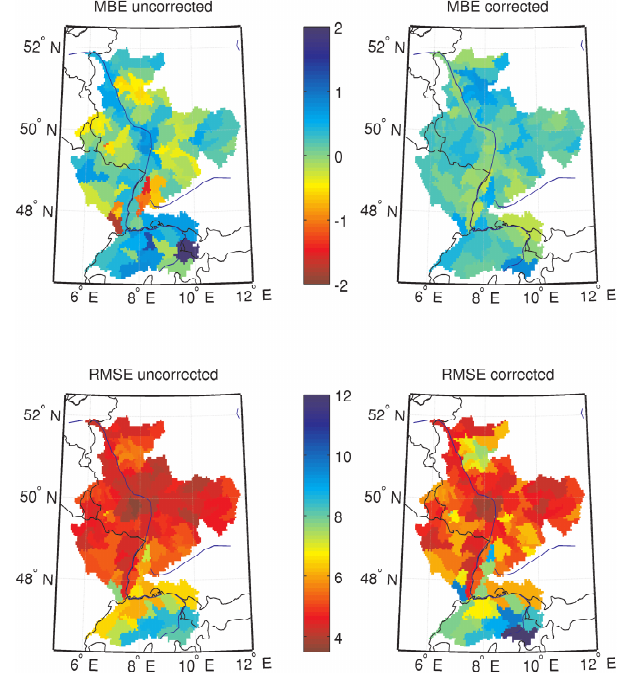
Fig. 14. Top: MBE for the uncorrected and corrected ERA15/REMO precipitation [mm] per sub-basin for the validation period 1989–1995. Bottom: RMSE for the uncorrected and cor- rected ERA15/REMO precipitation [mm] per sub-basin for the val- idation period